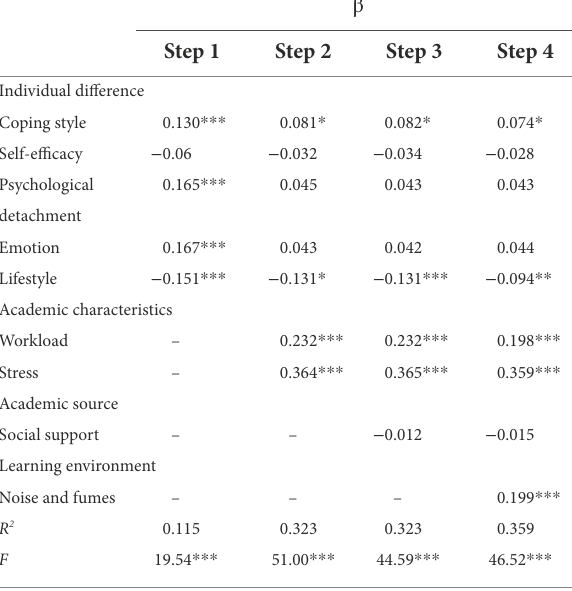
TABLE 2 Hierarchical multiple regression analysis for risk factors of academic-related fatigue.